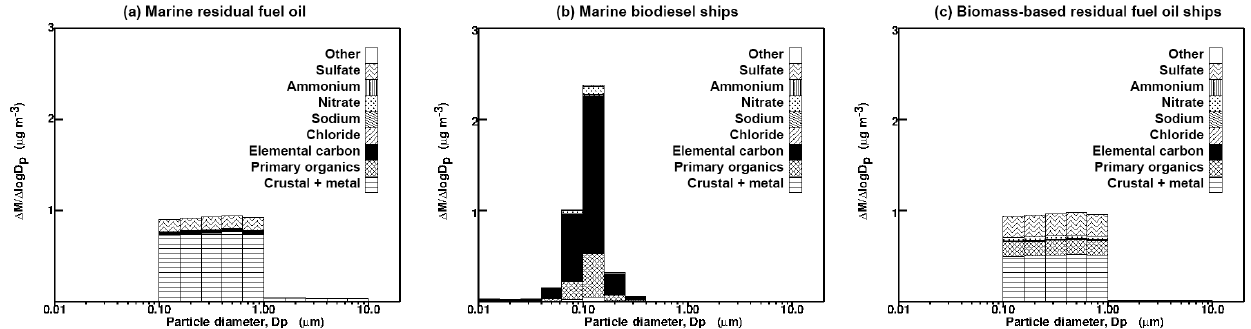
Figure 8. Particle emissions size and composition distribution for ships powered by marine residual oil (a) , marine biodiesel (b) , and biomass-based residual fuel oil (c)